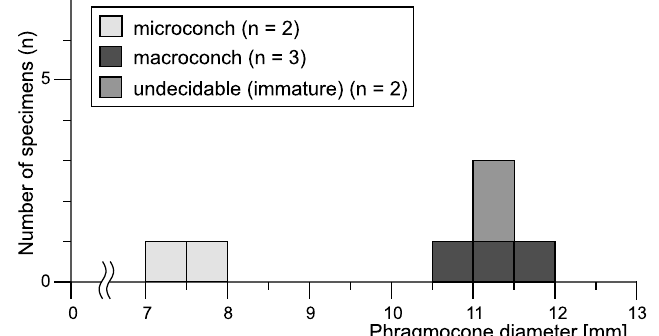
Fig. 6. The size distribution in a single horizon: outcrop HR109 (Santonian) in the Horotatesawa Creek of the Kotanbetsu area, Hokkaido,